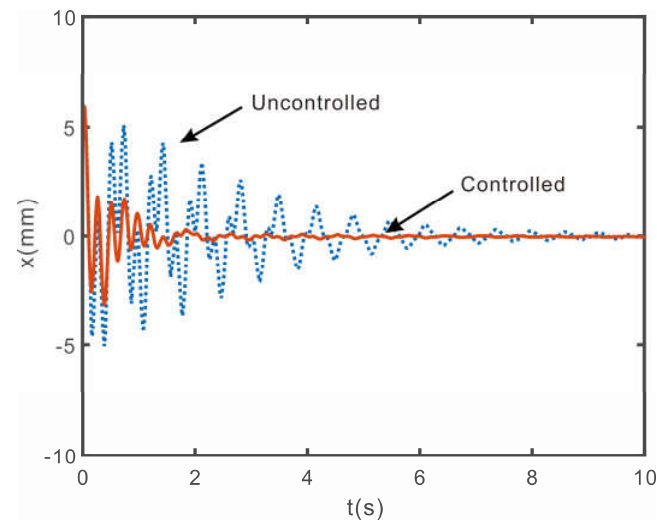
Figure 20. Free vibration experiment (the second mode excited).